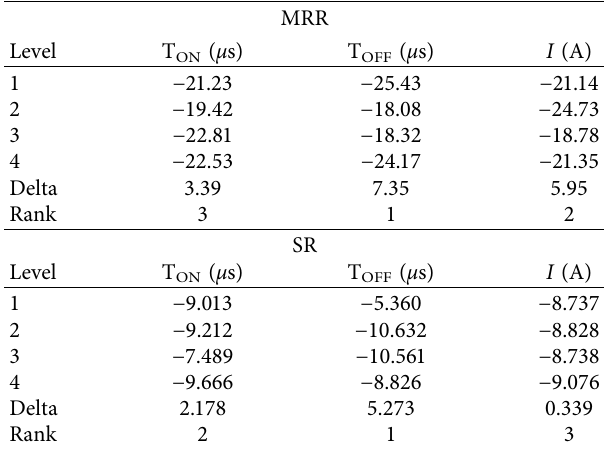
Table 3: Mean of SN ratios for the MRR and